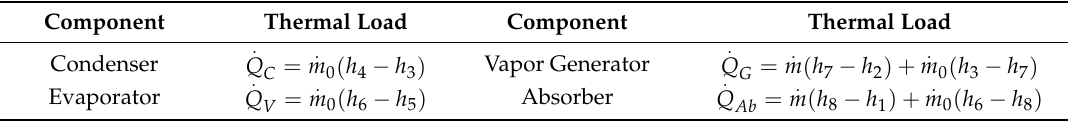
Table 3. Heat rates in the